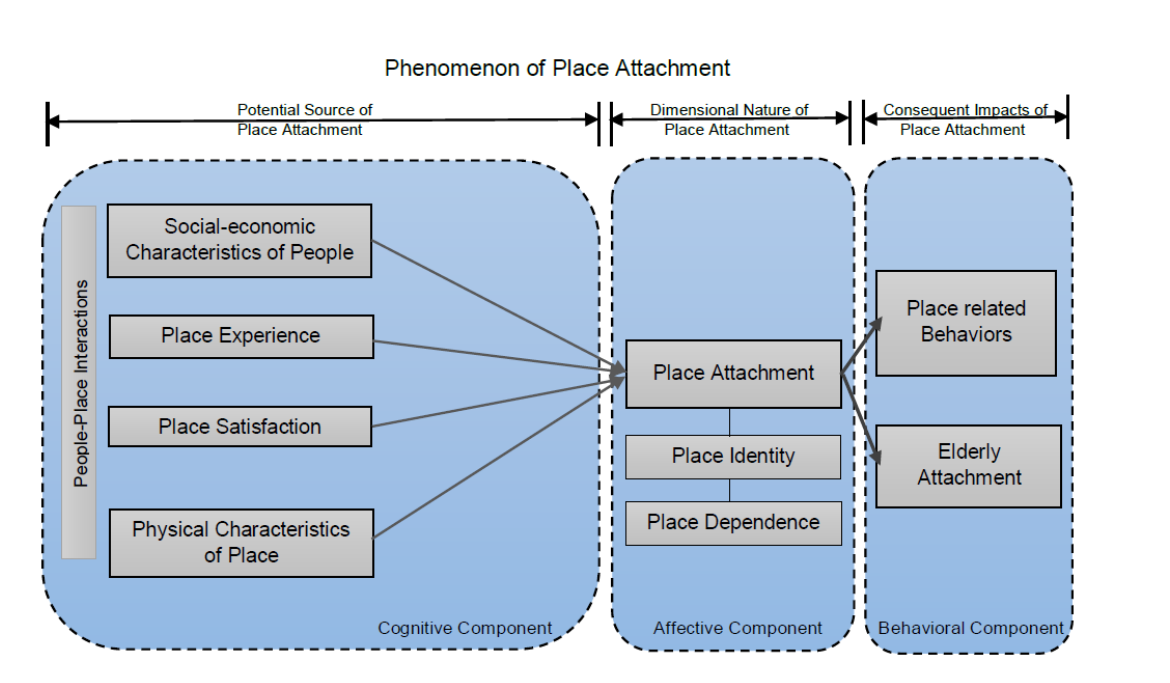
Figure 2 : A Conceptual Framework of Place Attachment and Elderly’s